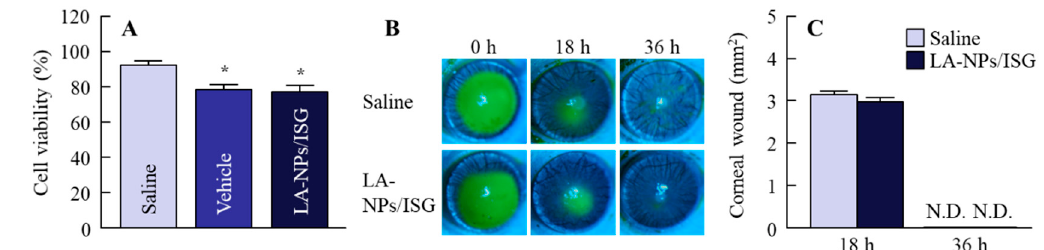
Figure 2. Corneal toxicity of LA-NPs / ISG in the HCE-T cells and rats. ( A ) E ff ect of LA-NPs / ISG on the viability in HCE-T cells. The HCE-T cells in 96-well microplates were treated with LA-NPs / ISG for 120 s. ( B , C ) Corneal images ( B ) and corneal wound healing ( C ) of rats repetitively instilled with LA-NPs / ISG. N.D., not detectable. Vehicle is solution consisting of benzalkonium chloride (BAC), mannitol, HPCD, and MC. n = 5–7. * p < 0.05, vs. Saline for each group. The viability in HCE-T cells treated with LA-NPs / ISG was similar to that of the vehicle, and the corneal wound healing showed no di ff erence between that in the rats instilled with saline and LA-NPs /